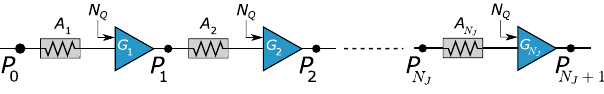
FIG. 15. Modeling of the STWPA as a cascade of attenuators =N and amplifiers. Every attenuator A is equal to A and i J TWPA ; LP =N every amplifier G is equal to G . We make the i J TWPA assumption that every amplifier is quantum limited with an input ¼ 1 = 2 noise N Q